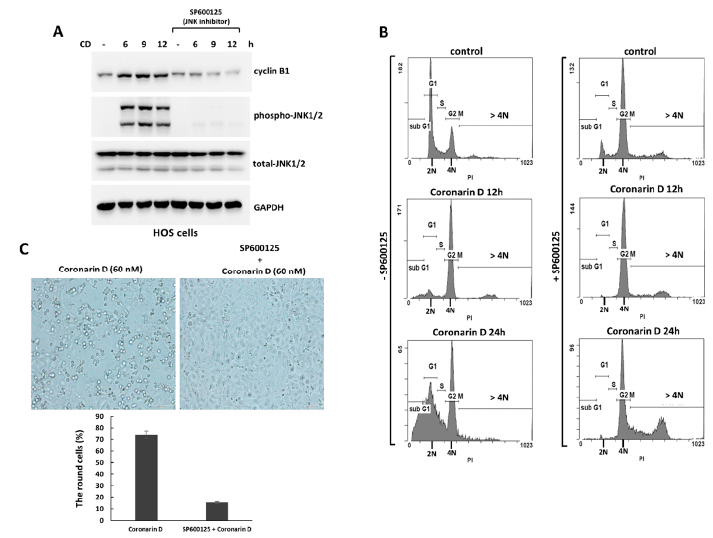
Figure 4. JNK inactivation blocks mitotic entry and induces polyploidy in coronarin D-treated HOS cells. ( A ) JNK inhibitor inhibited the accumulation of cyclin B1 in HOS cells. HOS cells were pretreated with JNK inhibitor, SP600125 (20 μ M) for 1 h, and cotreated with coronarin D (60 nM) and harvested in the indicated time points. The treated cells were analyzed by Western blotting using the indicated antibodies. ( B ) JNK inhibitor induces polyploidy in coronarin D-treated HOS cells. HOS cells were treated as described in (A). The treated cells were harvested in the indicated time points. The cells were stained with propidium iodide and analyzed by a flow cytometer. ( C ) Round mitotic cells were greatly reduced by cotreatment with SP600125. Phase-contrast photomicrographs of HOS cells treated with coronarin D (60 nM) in the absence or presence of JNK inhibitor (SP600125) (20 μ M) for 12 h.